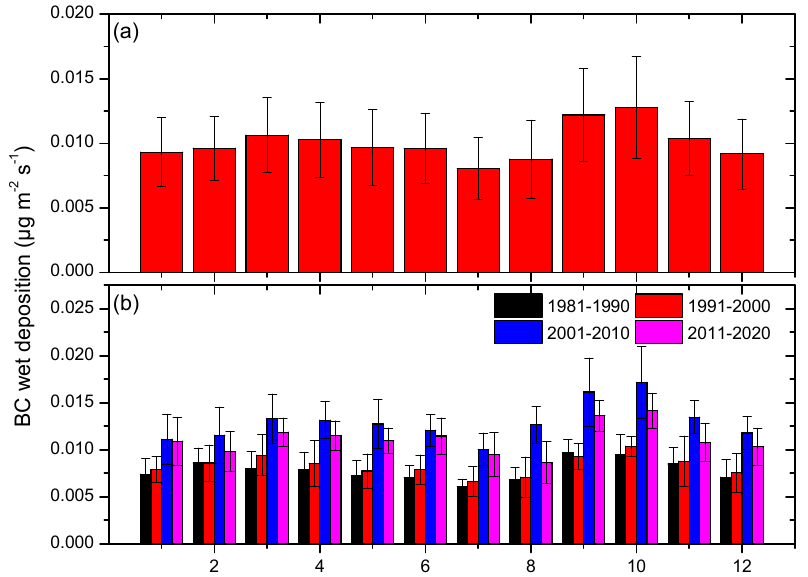
Figure 7. Monthly variations of area-averaged black carbon wet deposition flux over the Sichuan basin from 1981 to 2020 ( a ) and in four periods ( b ) during 1981–1990, 1991–2000, 2001–2010, and